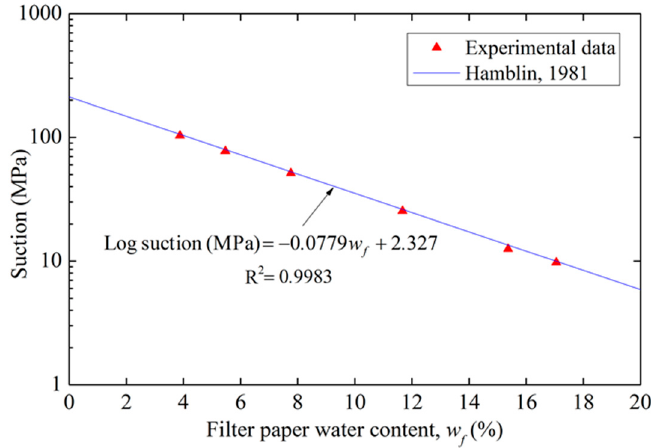
Figure 4. Calibration curve for Whatman No.42 filter paper ( w f <20%).